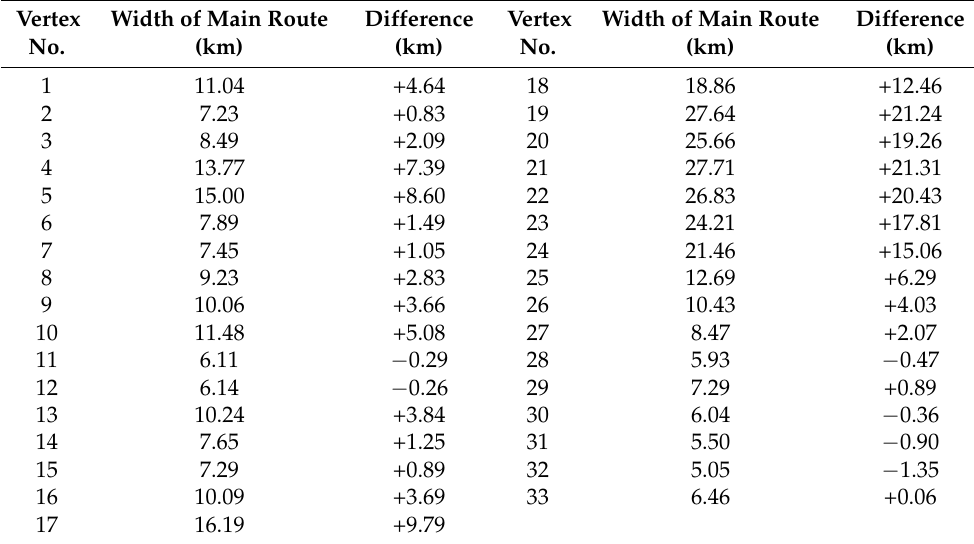
Table 5. Summary of the main route width and PIANC calculation